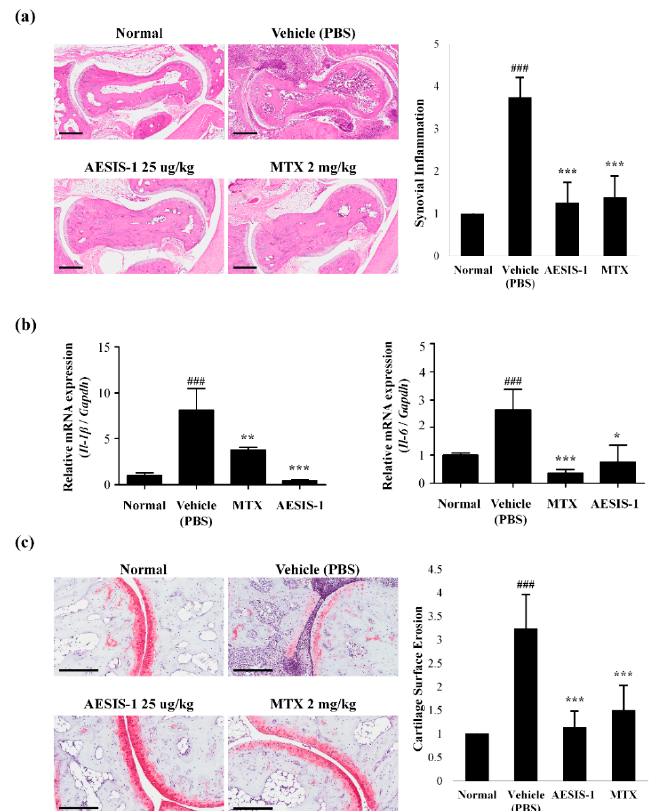
Figure 2. AESIS-1 suppressed synovial inflammation and cartilage destruction in vivo. ( a ) Histological analysis of 8 μ m sections from paraffin-embedded hindlimb tissue stained with hematoxylin and eosin. Photographs are of representatives from each group (scale bar, 300 μ m). Degree of synovial inflammation was evaluated on a scale from 0 to 4; ( b ) The mRNA expression of proinflammatory cytokines Il-1 β and Il-6 was determined by real-time PCR of total RNA isolated from the tissues. The relative mRNA expression level was set to 1 for the normal control; ( c ) For examination of cartilage degradation in synovial tissues, sections were stained with safranin O. Photographs are of representatives from each group (Scale bar, 60 μ m). Degree of cartilage surface erosion was also evaluated on a scale from 0 to 4. ANOVA with Tukey’s post hoc tests was used for statistical analysis. ### p ≤ 0.001, compared with normal group. * p ≤ 0.05, ** p ≤ 0.01, and *** p ≤ 0.001, compared with vehicle (PBS) group.